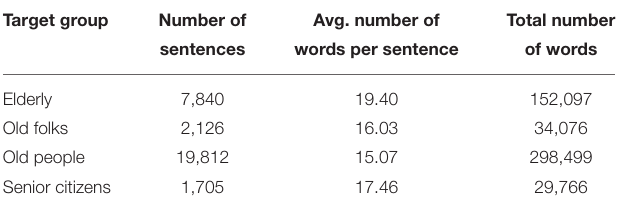
TABLE 7 | The number of extracted sentences with the target as nominal subject and the average and total number of words (sequences of alpha-numeric characters) in the sentences for each age-related target